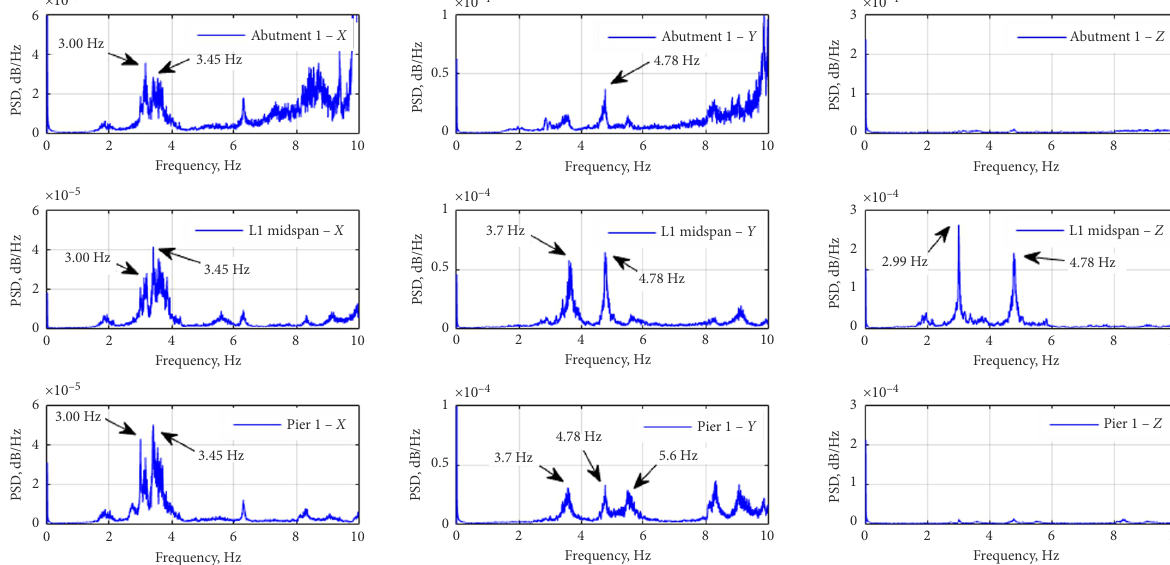
Figure 12. Frequency domain presentation of the signals for the first set of measurements in the second Ambient